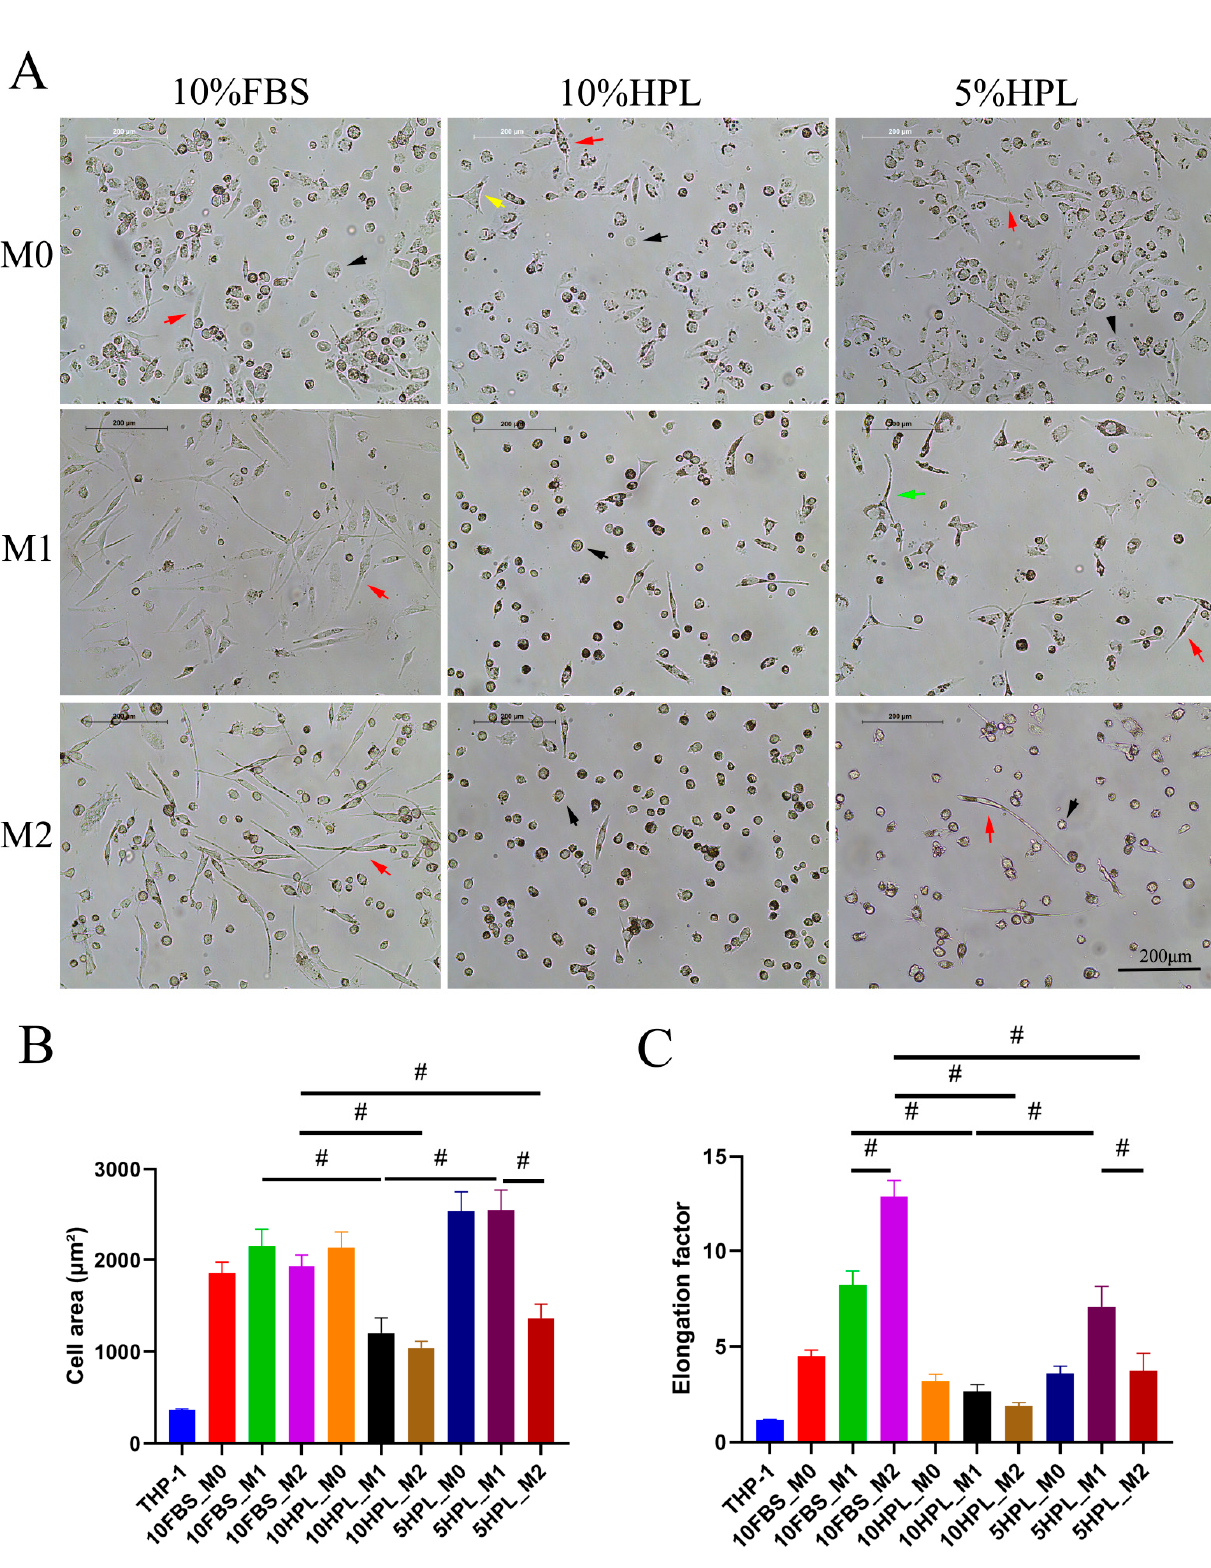
Figure 2. Cell morphology of PMA-(M0)-induced THP-1 cells, which were further differentiated into M1 and M2 macrophages cultured under FBS or hPL supplementation. ( A ) Phase contrast microscopic pictures of M0, M1, or M2 macrophages under 10% FBS, 10% hPL, or 5% hPL culture supplementation (black arrow: round cell; red arrow: fibroblast-like cell; yellow arrow: triangular cell; green arrow: polygonal cell); scale bar: 200 µ m. ( B ) Analysis of the cell area of M0, M1, and M2 macrophages ( n = 30 cells per group, # p < 0.05). ( C ) Analysis of the elongation factor of M0, M1, and M2 macrophages ( n = 30 cells per group, # p <